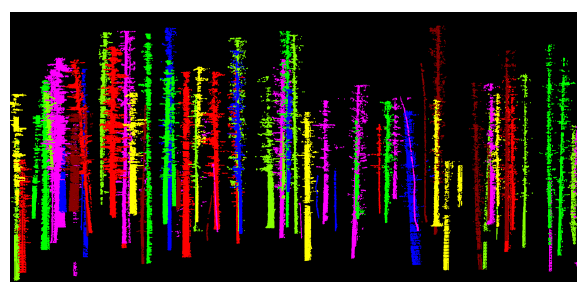
Fig.5 A part of extracted tree trunks by our system